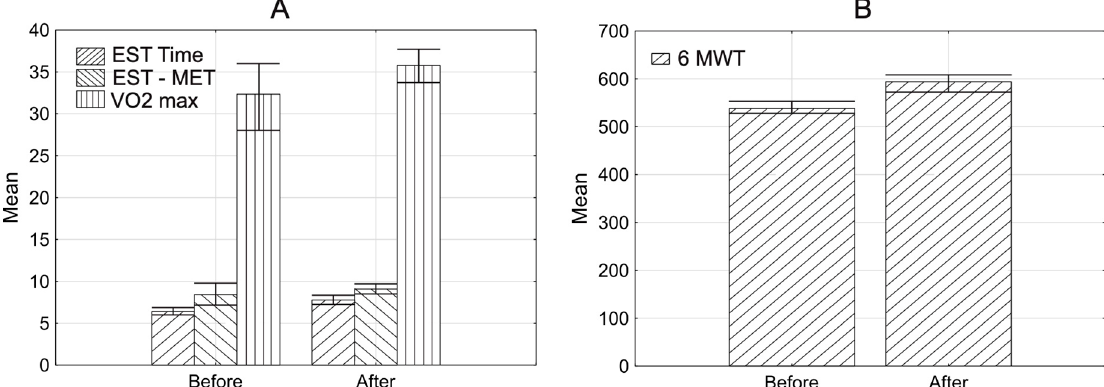
Figure 3. Characteristics of examined group. Mean before and after rehabilitation in the 3rd phase of rehabilitation. ( A ) exercise stress test time (EST time), exercise stress test MET (EST MET), VO2max. ( B ) 6MWT; p < 0.05. Table 4. Comparative characteristics of the examined group in terms of: exercise stress test time, exercise stress test MET, VO2max, DPr, and 6-min test measured at baseline and after rehabilitation.